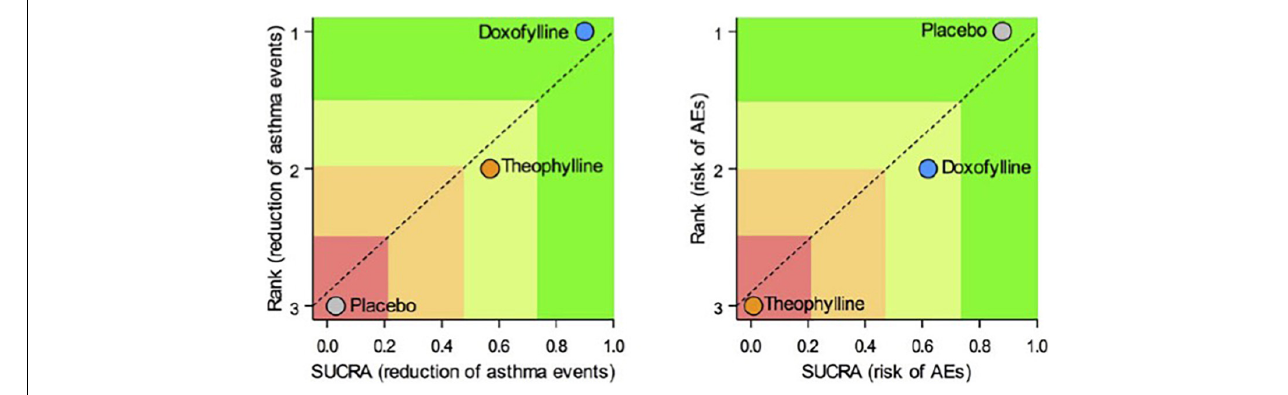
FIGURE 4 | Safety and efficacy of doxofylline compaired to theophylline (59).